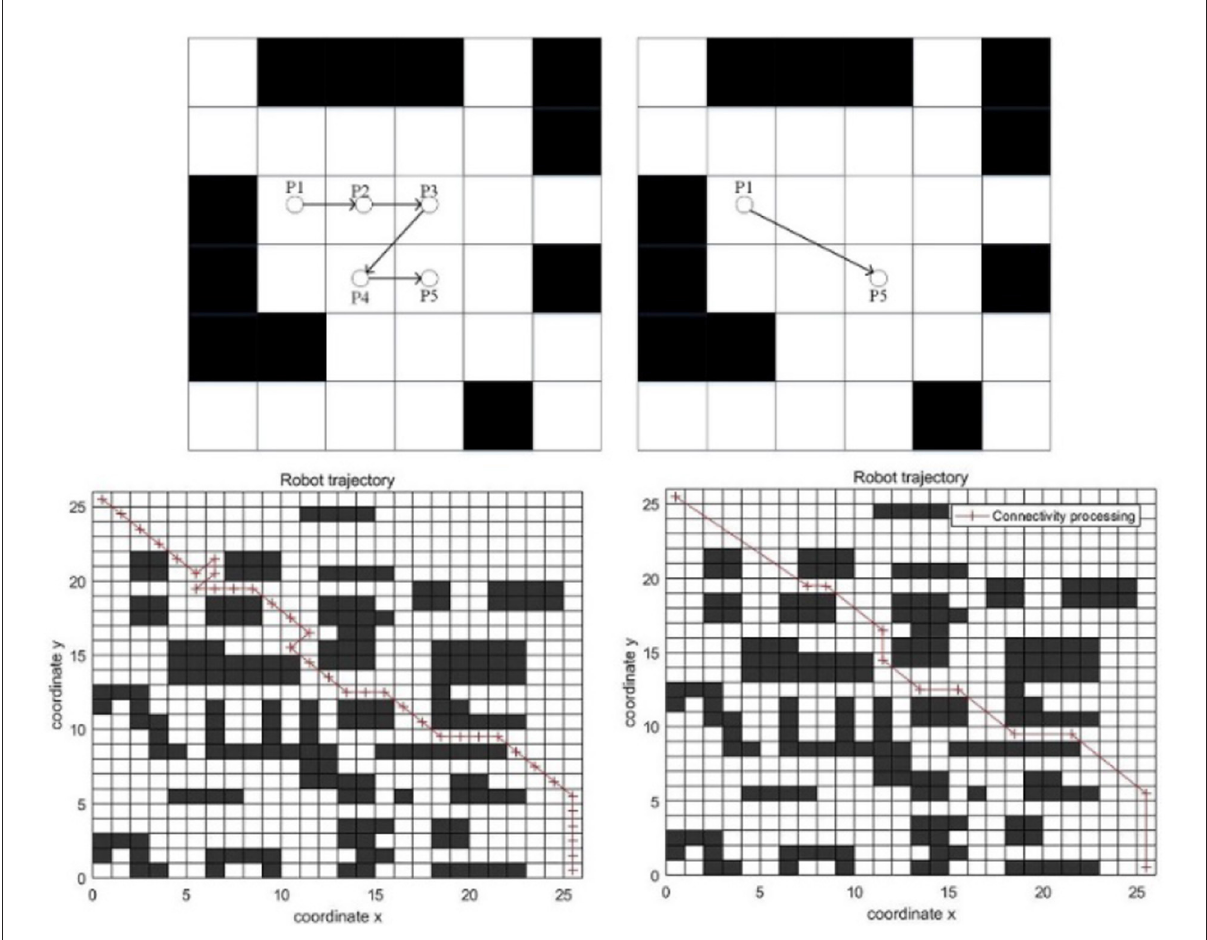
FIGURE7 Connectivity